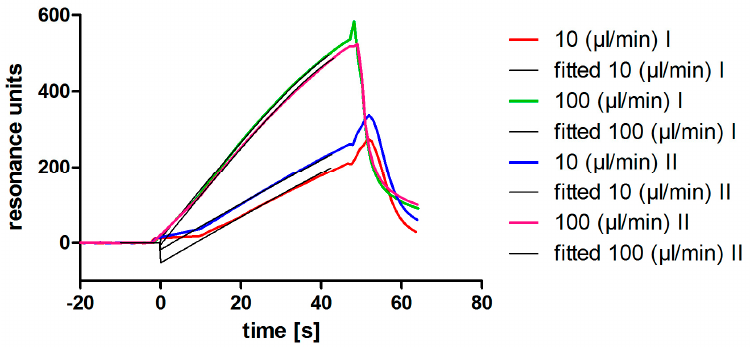
Figure 2. Single cycle kinetics of L-selectin LE-His in cell culture supernatant using SPR. ( A ) triplicate of the kinetic titration is shown. Symbols mark binding levels that will be plotted against the respective concentrations shown in ( B ) binding levels are plotted against corresponding concentrations. Extrapolated R max and respective K D at R max /2 are marked by dotted lines.